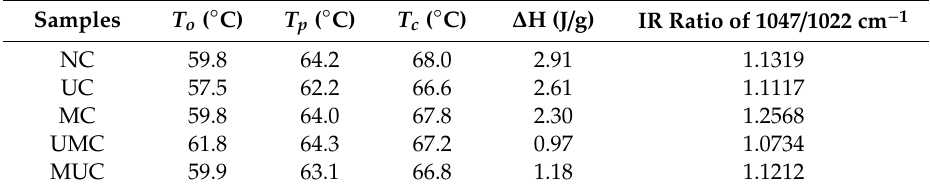
Table 1. Thermal, FTIR spectra and pasting parameters of native and modified chestnut